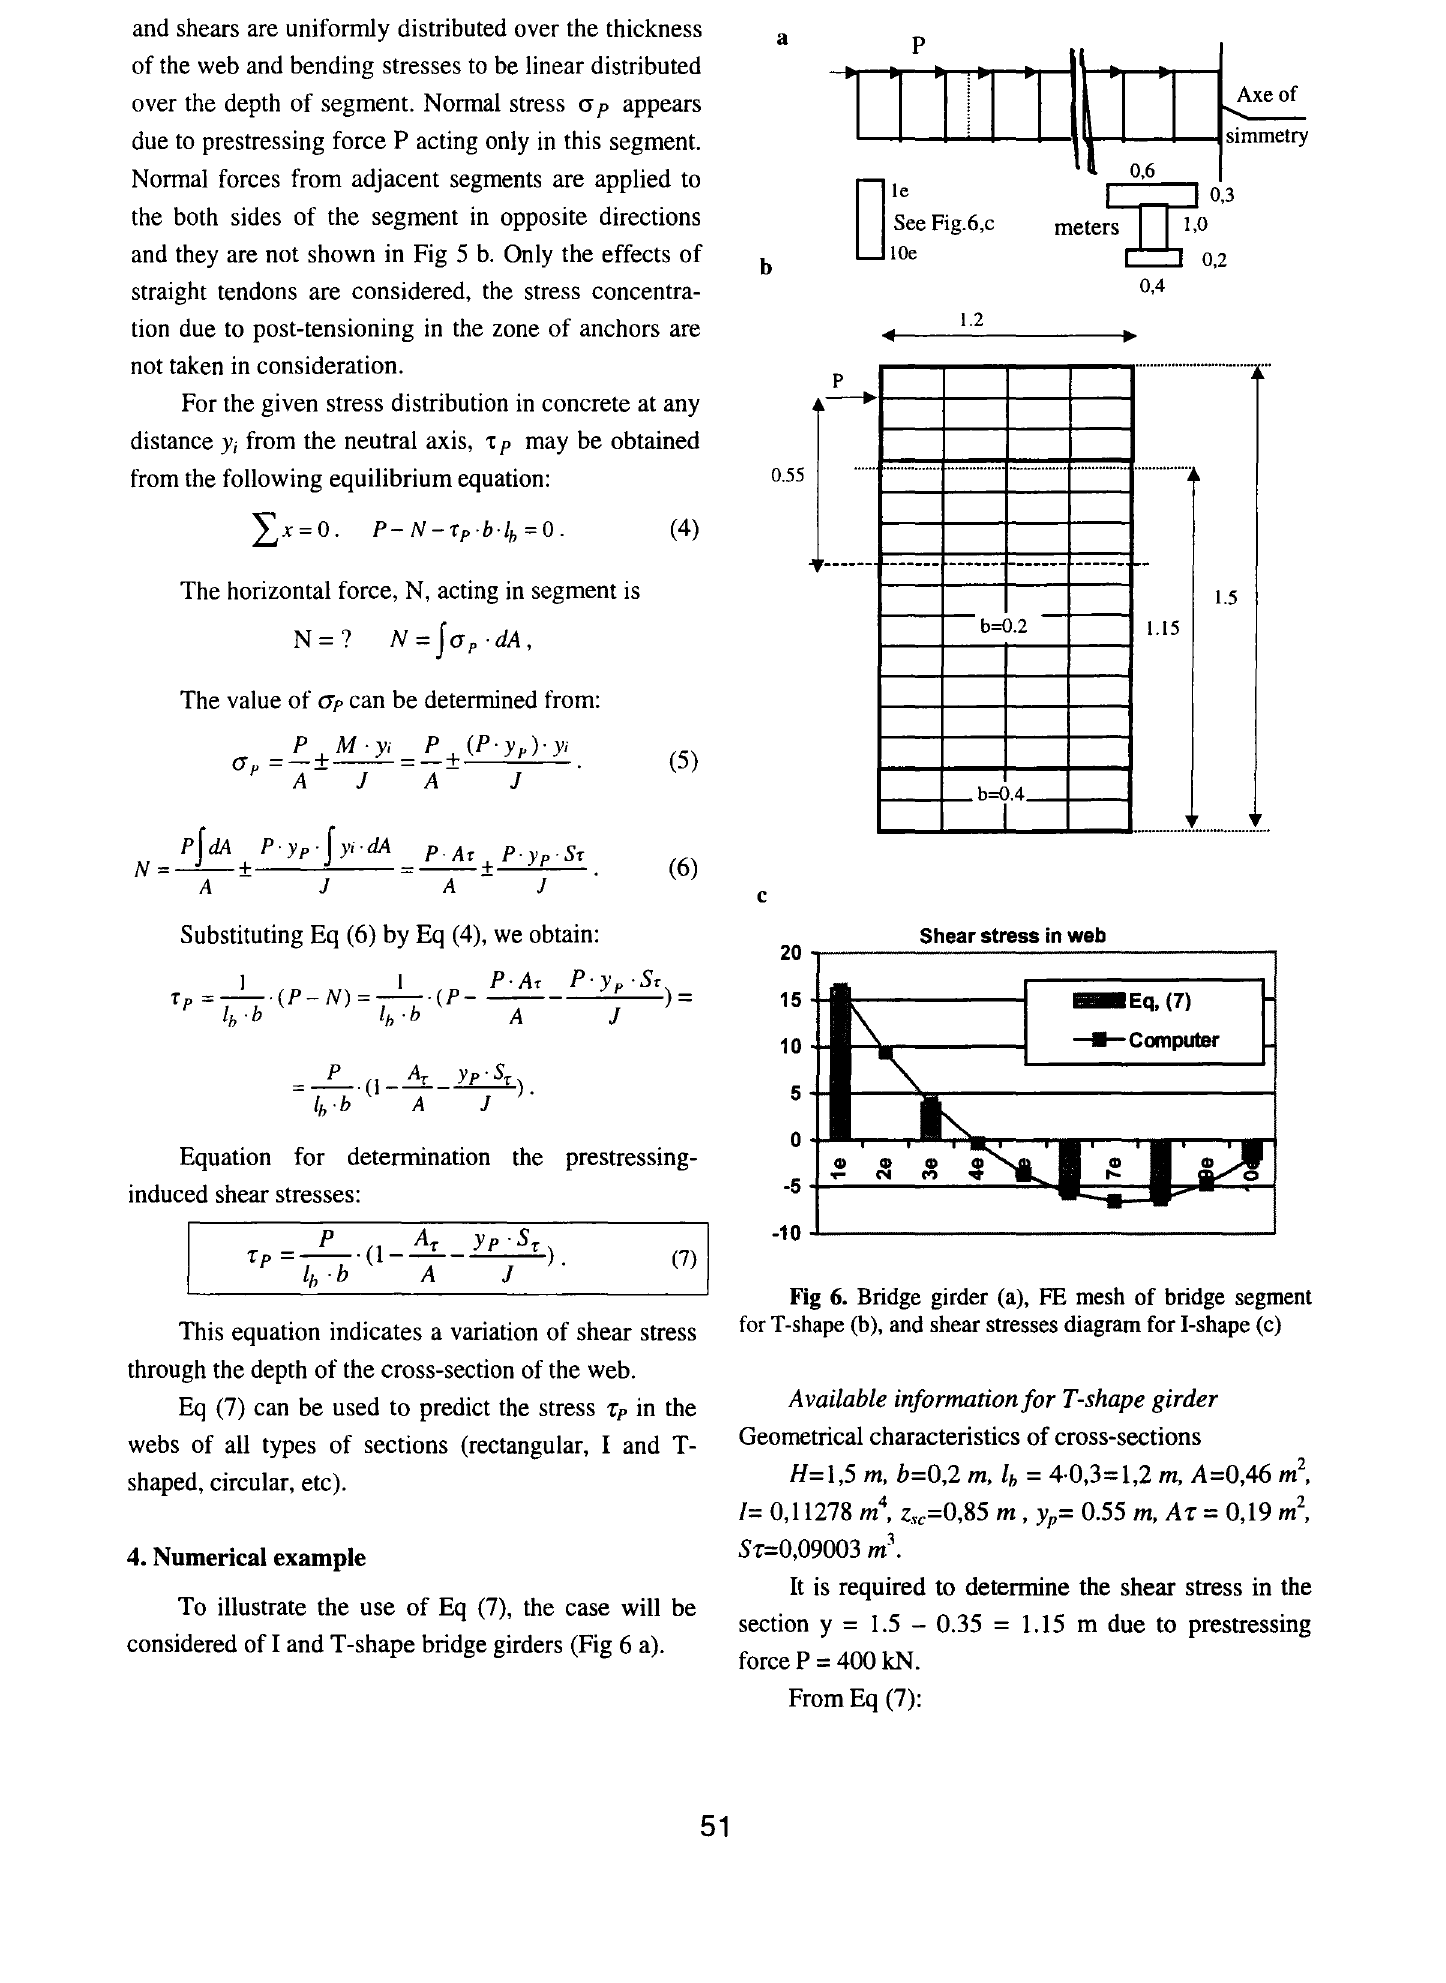
Fig 6. Bridge girder (a), FE mesh of bridge segment forT-shape (b), and shear stresses diagram for 1-shape (c) Available information for T-shape girder Geometrical characteristics of cross-sections H=1,5 m, b=0,2 m, lb = 4·0,3=1,2 m, A=0,46 m 2 , Sr=0,09003 m 3 • It is required to determine the shear stress in the section y = 1.5 - 0.35 = 1.15 m due to prestressing = force P 400